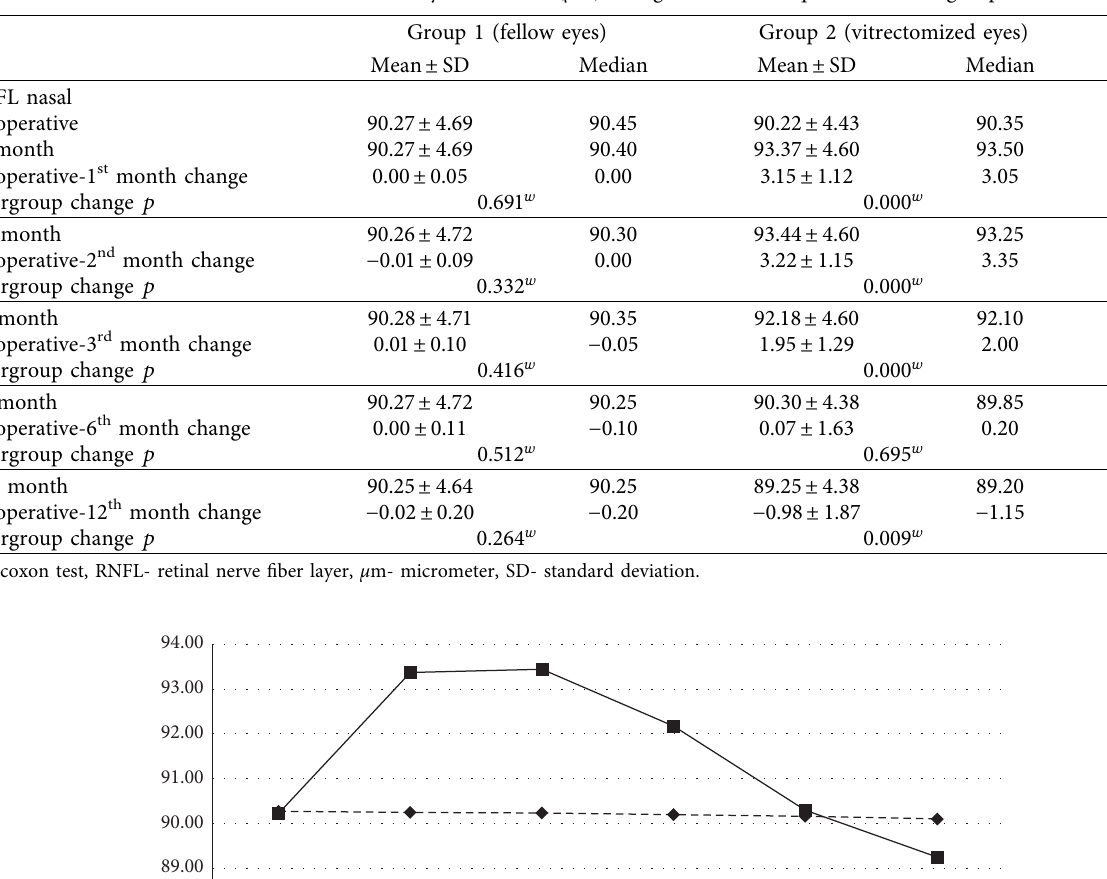
Table 2: Retinal nerve fiber layer thickness ( μ m) change in the nasal quadrant of the groups.